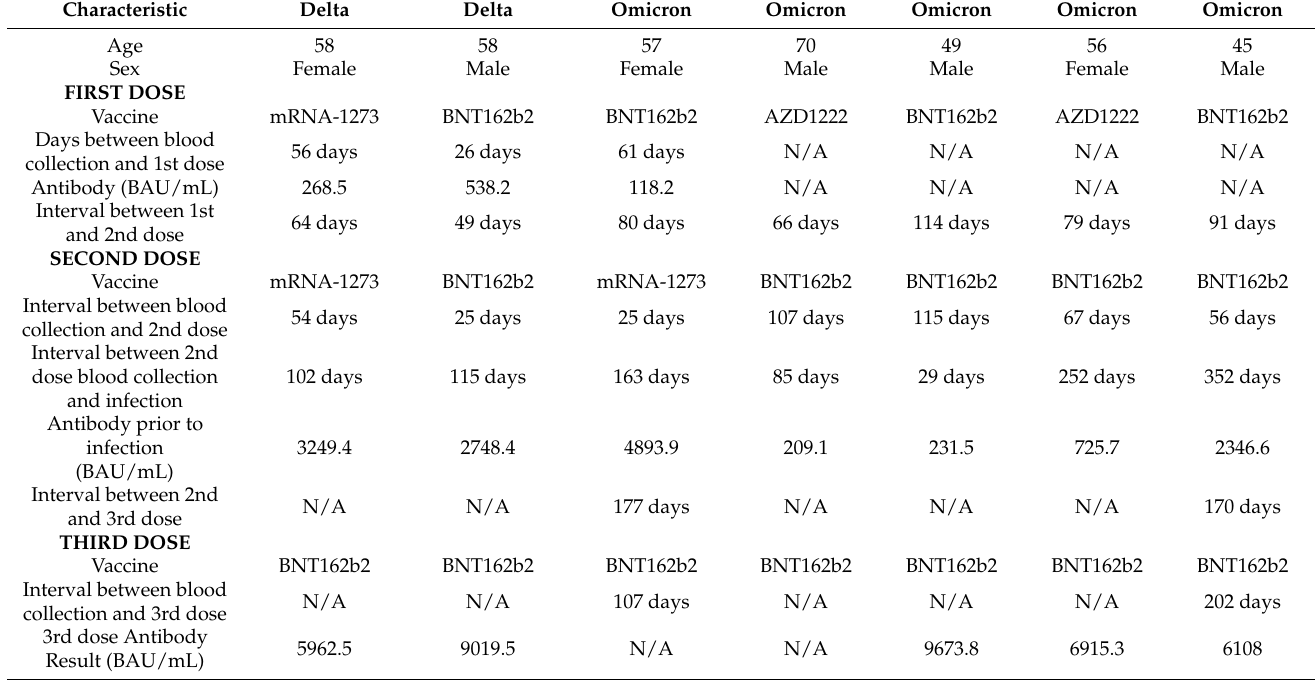
Table 2. Characteristics of seven breakthrough cases confirmed by PCR and